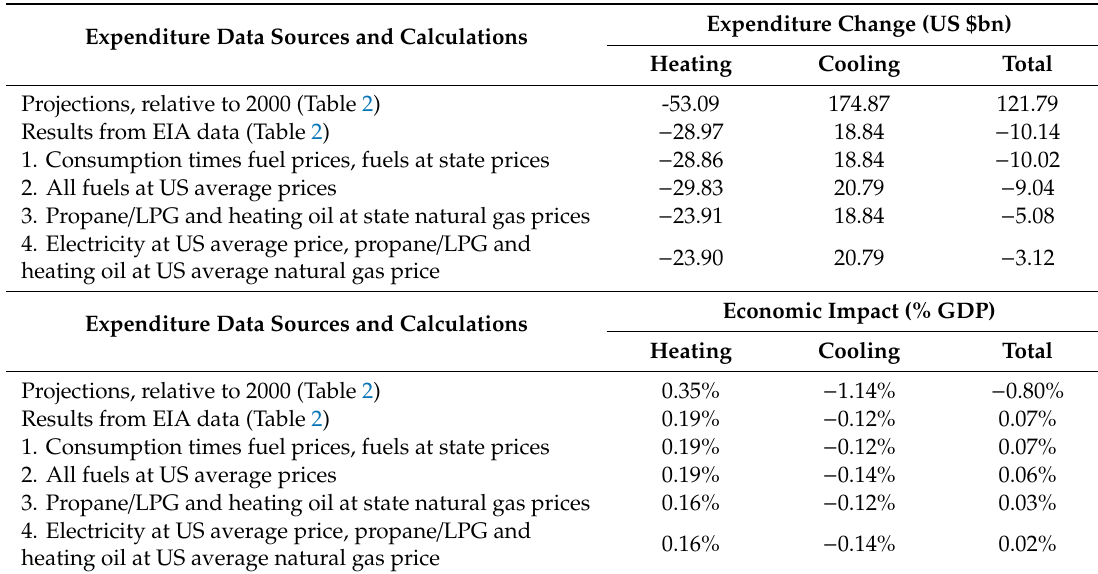
Table A6. Comparison of the e ff ect of di ff erent fuel consumption proportions and fuel prices in di ff erent states on the economic impact of 3 ◦ C GMST increase, relative to 2000, on US space heating and space cooling energy expenditure. The projections are included for